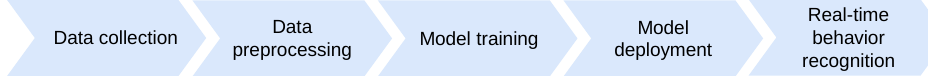
Figure 6. The flowchart of